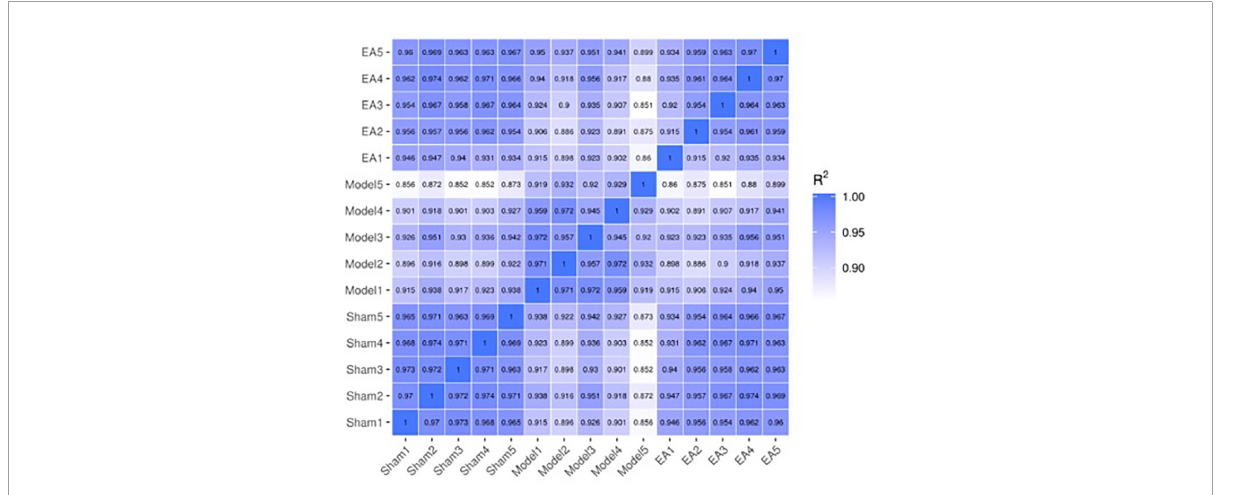
FIGURE3 Correlation heat map between samples. The correlation heat map between samples is often used to evaluate the sample difference between groups and the sample repetition within groups. The X -axis and Y -axis in the above figure are sham group (sham1, 2, 3, 4, and 5), model group (model1, 2, 3, 4, and 5) and EA group (EA1, 2, 3, 4, and 5). The values between the X -axis and Y -axis are the square of the correlation coefficient between the corresponding samples. The darker the color indicates the higher the correlation coefficient between samples, and the lighter the color indicates the lower the correlation coefficient between